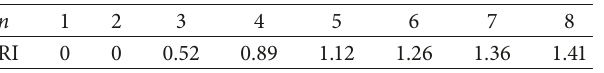
Table 3: The value of the mean random consistency index RI of n - order decision judgment matrix.